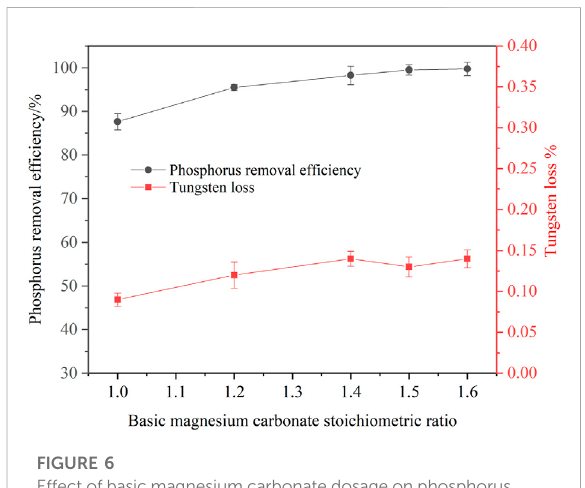
FIGURE 6 Effect of basic magnesium carbonate dosage on phosphorus